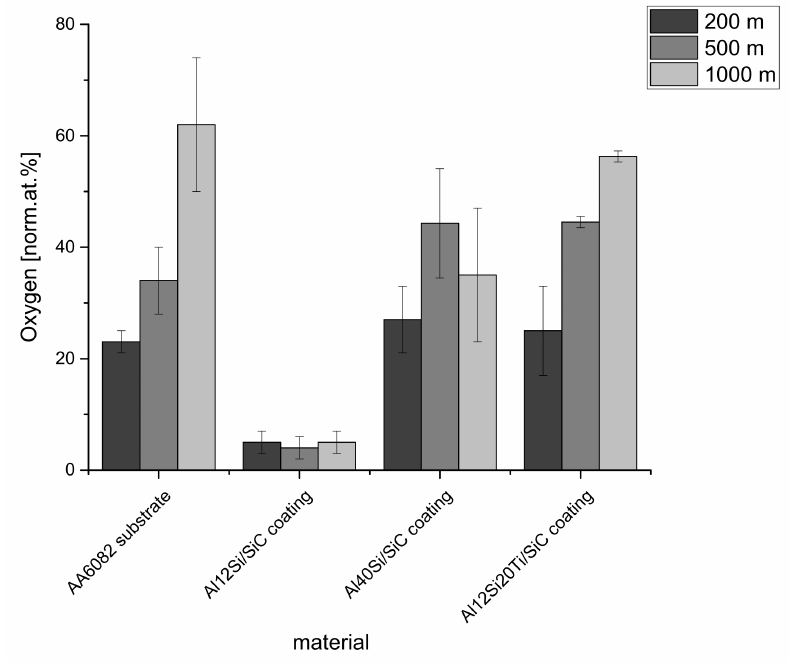
Figure 10. Oxygen percentage [norm. at.%] present on the debris obtained in the wear tests of the uncoated AA6082 and the different coatings (Al12Si/SiC, Al40Si/SiC, and Al12Si20Ti/SiC) compared to the sliding distances (200 m, 500 m, and 1000